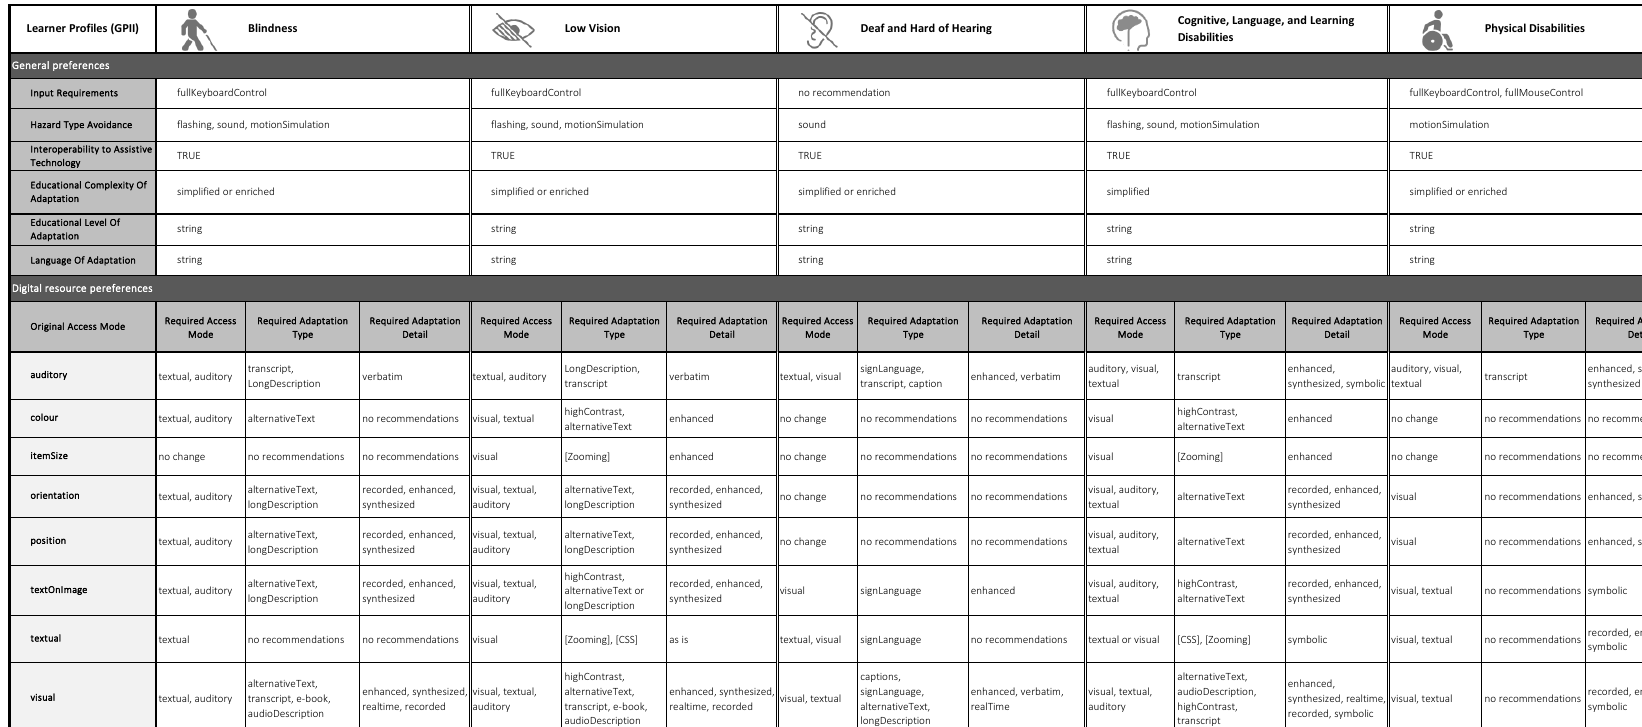
Figure 2. Learner input profile. (The images in the table are taken from https://icons8.com under the Creative Commons Attribution-NoDerivs 3.0 Unported